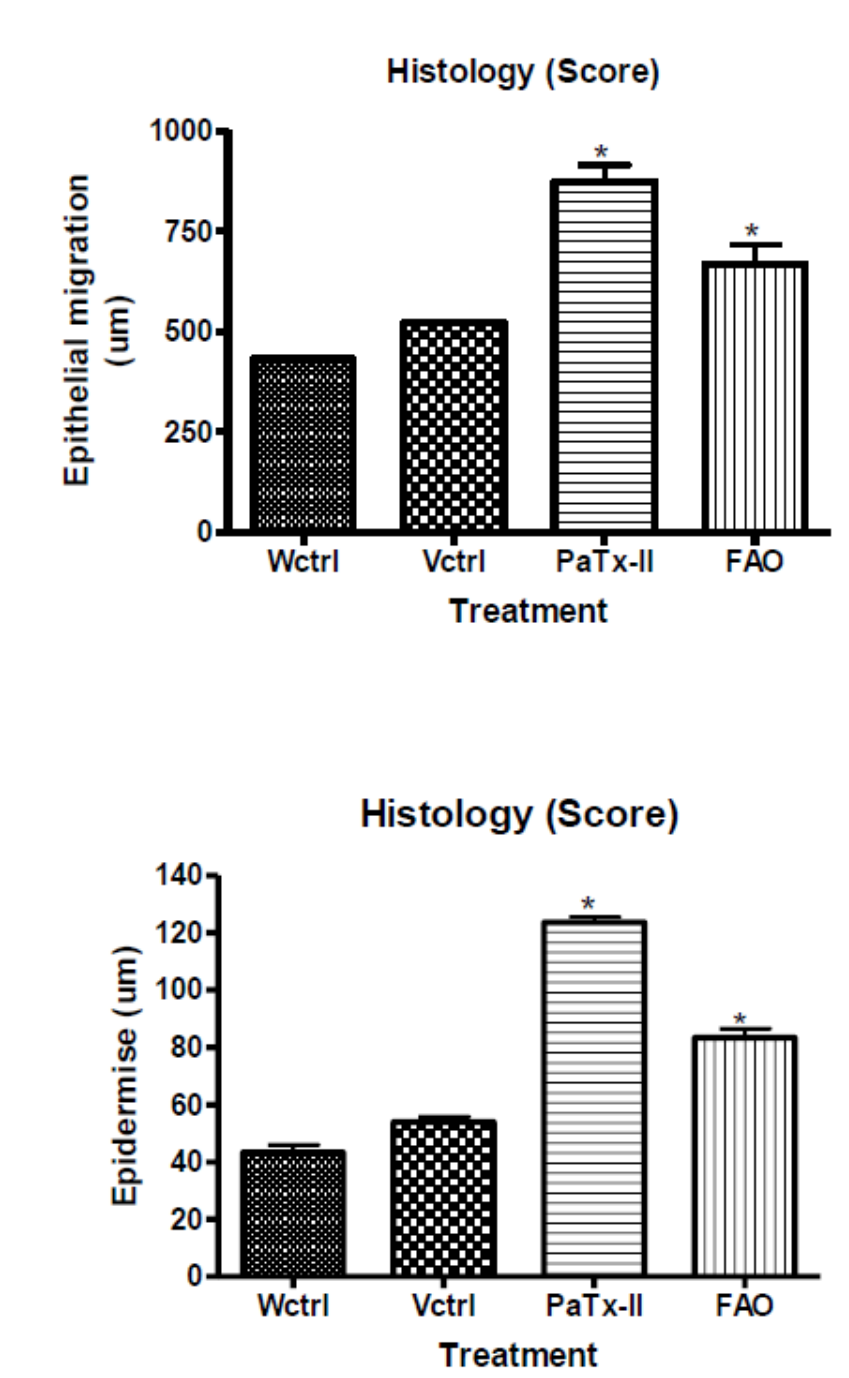
Figure 5. ( A ) Pathological assessment of wounds before and after treatment was evaluated under the light microscope. Group (I): WCtrl mice show redness and inflammation. Group (II): Among VCtrl mice, there was necrosis (nc) and abundant inflammatory infiltrates, changes in the muscle fibers (mf) and almost complete destruction of the mf cells after injury on day 14. Group (III): PaTx-II locally applied to mice exerted significant healing and clearing of bacteria after 14 days. Group (IV): Two percent FAO-treated mice healed more slowly than the PaTx-II treatment group. Abbreviations: ep-epidermis, de-dermis, li-leukocyte infiltration, mf-muscle fiber, nu-neutrophils,